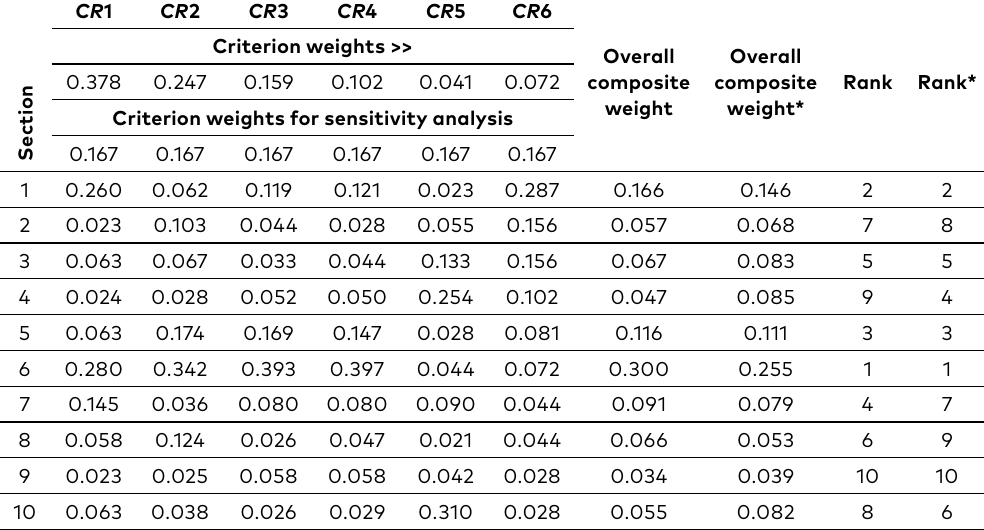
Table 12. The overall priority of the different accident